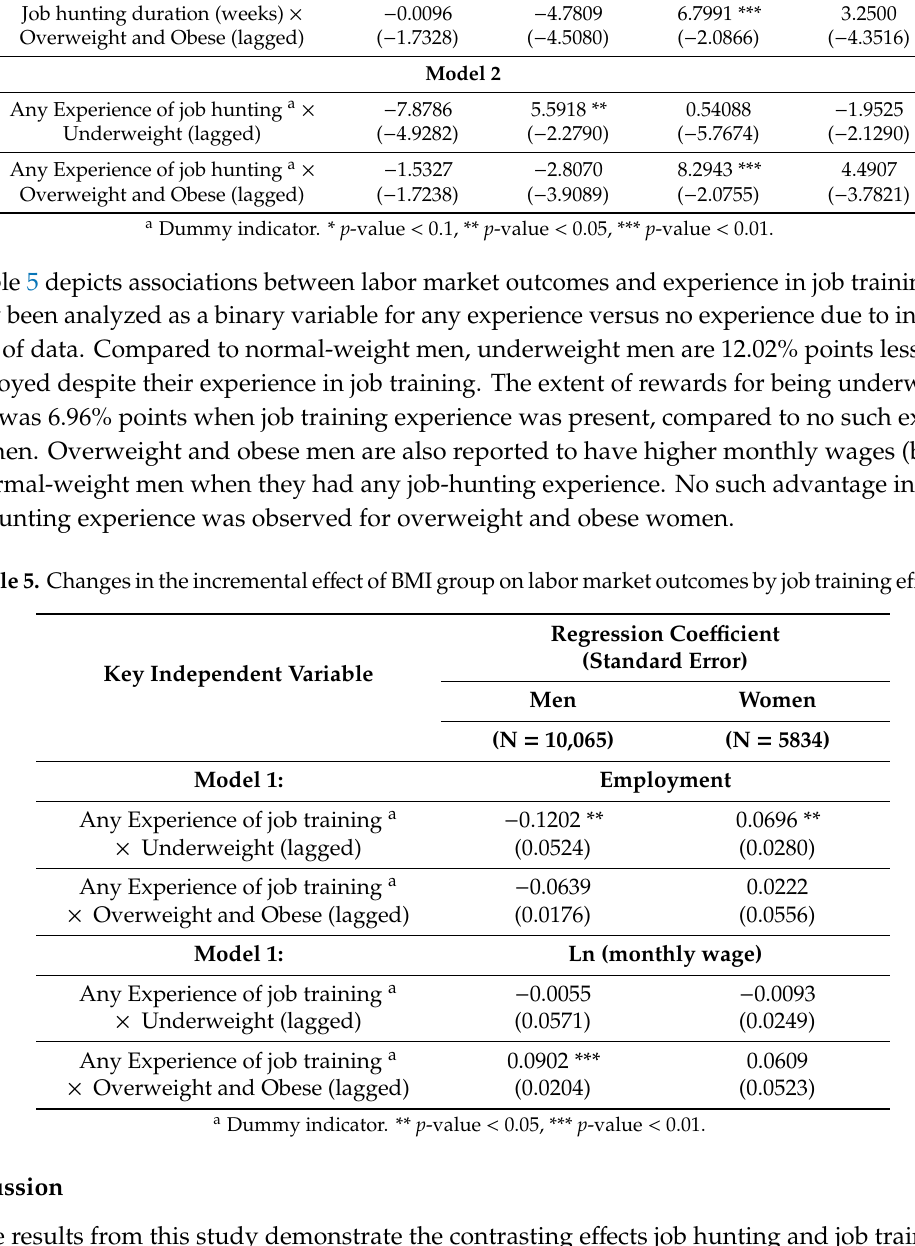
Key Independent